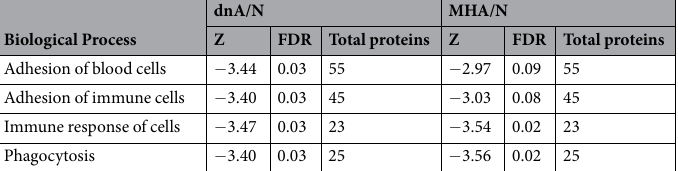
Table 1. Immune response categories significantly altered in hypertensive patients under chronic RAS suppression who develop albuminuria. A negative Z value indicates down-regulation in dnA or MHA versus N. The number of proteins included in each biological process (categories) is also indicated. N: normoalbuminuria; dnA: de novo albuminuria; MHA: maintained high